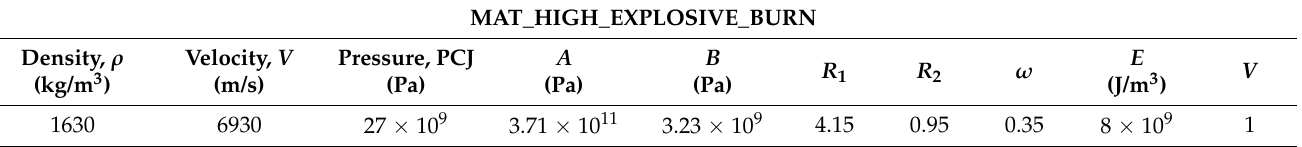
Table 1. Parameters of JWL state